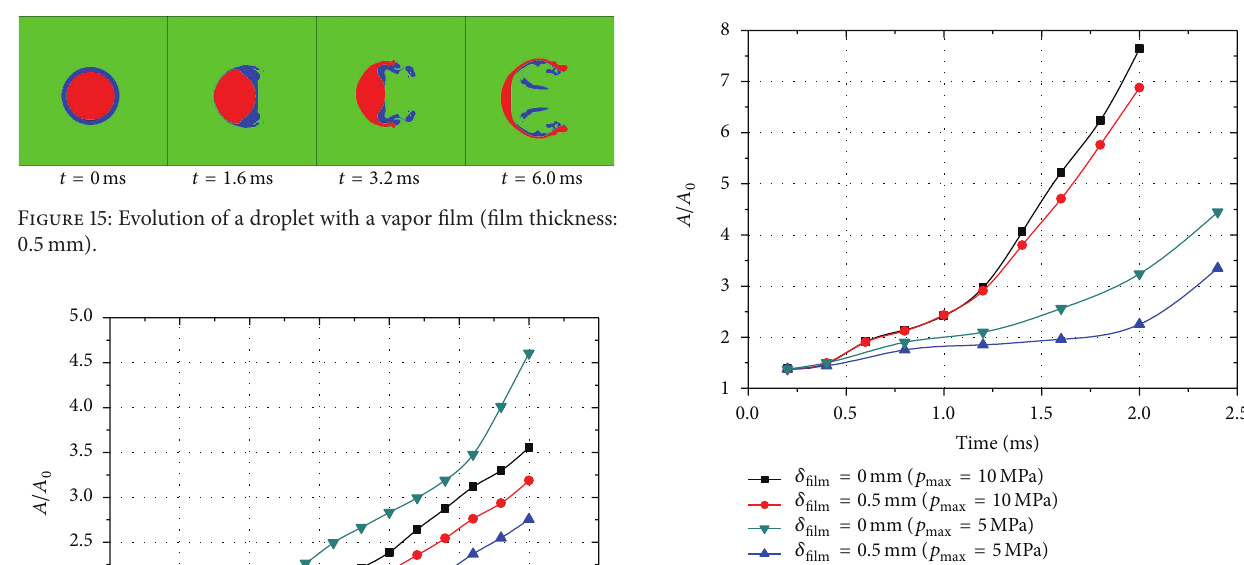
Figure 18: Aspect ratio of droplet diameter with time for the drop- lets with and without film (the peaks of pressure pulses are 10MPa and 5 MPa).